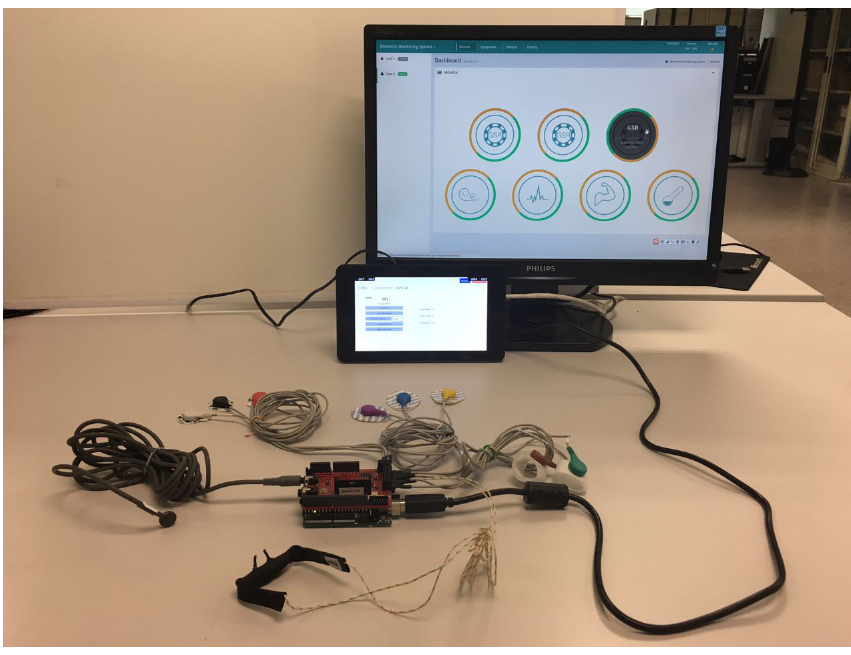
Figure 8. Sensor